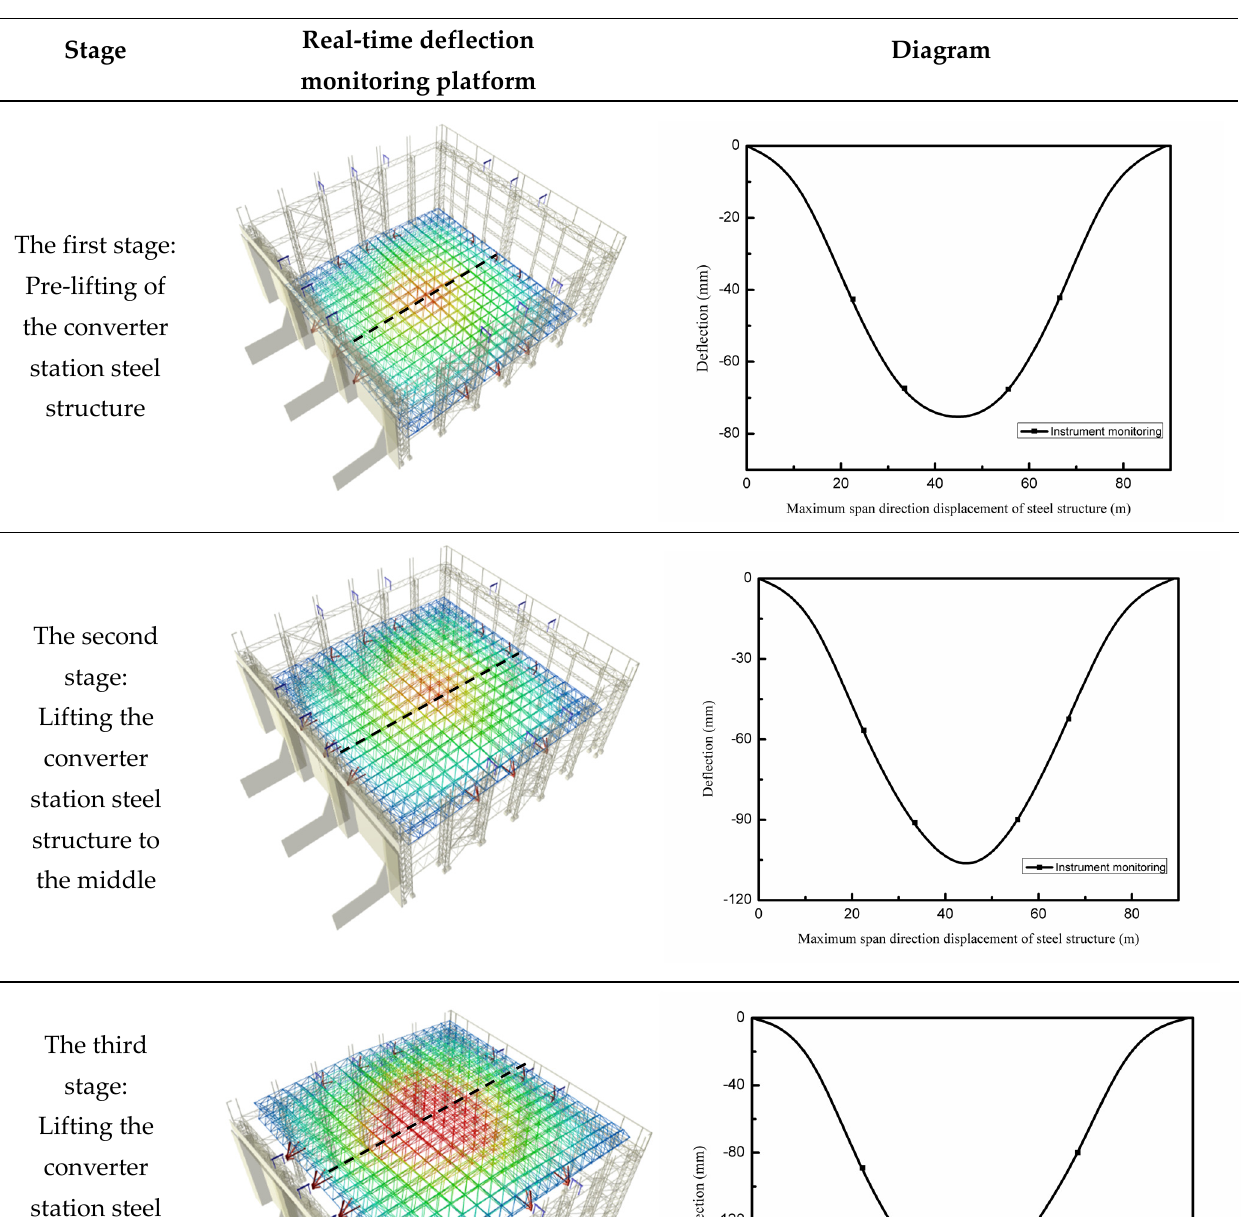
Figure 22. Deflection of selected members of the long − span converter station steel struc- ture.